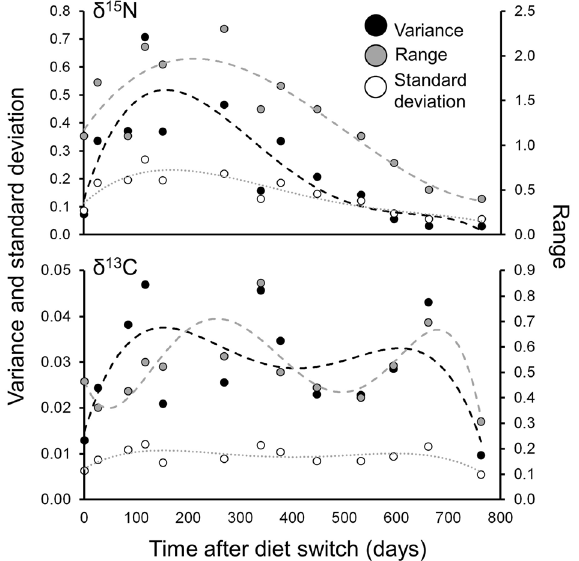
Figure 6. Variability of muscle δ 15 N and δ 13 C with time across individual California yellowtail Seriola dorsalis following a diet switch in captivity . Points represent individual measurements and dashed lines show associated polynomial model fits (solid lines) for various metrics of variability: variance (black), range (grey) and SD (white). Note that through the experimental period, variability was lowest at the beginning and end, representing steady-state with low δ 15 N and δ 13 C diet (pellets) and high δ 15 N and δ 13 C diet (fish/squid), respectively.